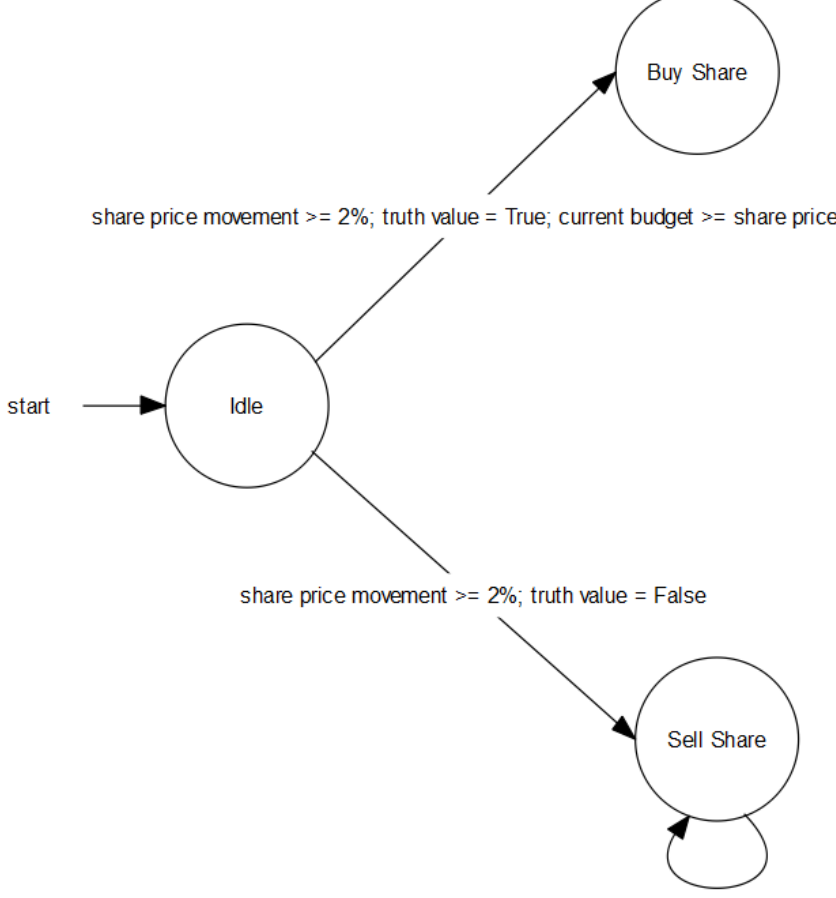
Fig. 2. Fourth evolution stage of the Non-Player Character Finite State Machine sions dependent on a certain positive or negative share price movement. In the soft- ware, a share price delta of two percent or more between the last turn and the current turn was used for triggering an action. This delta is called share price movement in the following evolution stages. Since the two strategies are contrary, a truth value, which is randomly assigned before each round, is needed to distinguish the conditions of the transitions to the buy state and the sell state, respectively. This truth value decides whether the NPC takes the cyclical or the anti-cyclical strategy. Also, the available budget of the NPC appears the first time and is added to the condition of the transi- tions to the buy state. This is a crucial step to ensure a realistic trade setting. The itera- tive transition from the buy state to the buy state is added as well. The NPC is